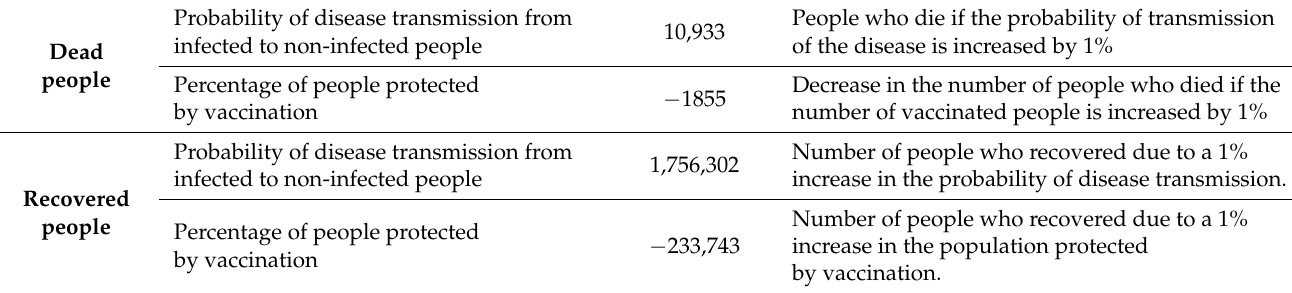
Table 2. Estimated sensitivity using response surfaces. Disease control measures: vaccine and protection measures affecting the probability of disease transmission from infected to non-infected